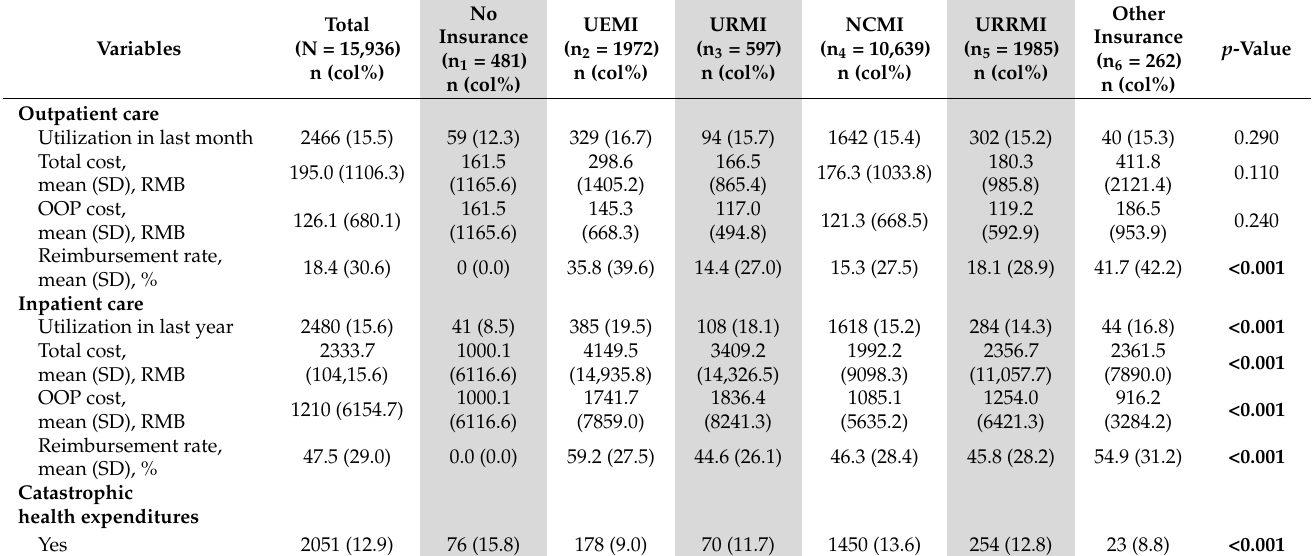
Table 3. Health care utilization and costs among older Chinese, 2018.